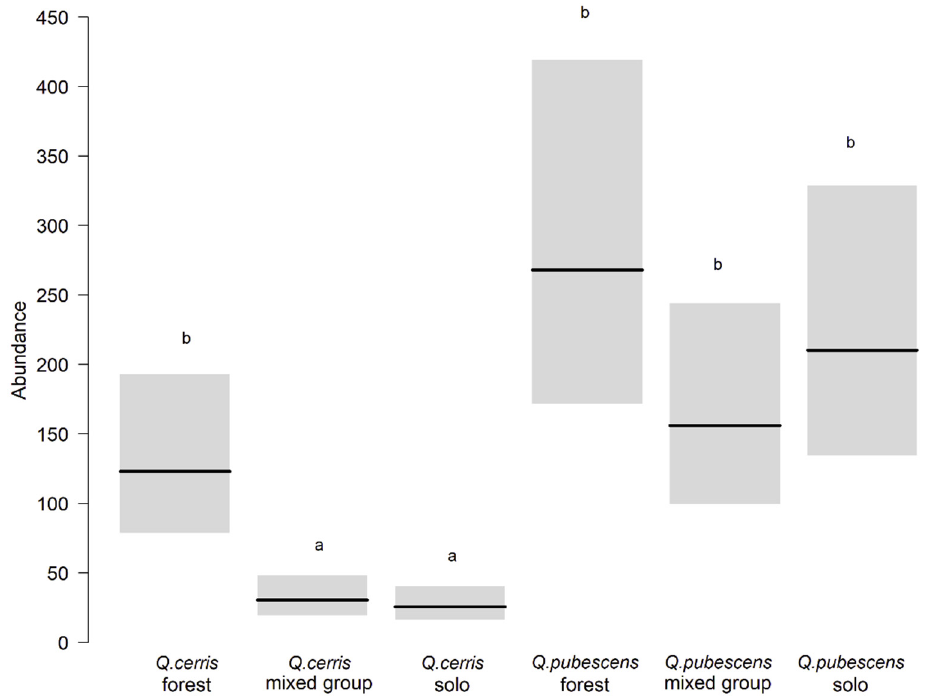
Figure 2. Abundance of caterpillars (number of individuals on three branches, each 1 m long) on mature LF Quercus cerris and EF Q. pubescens located in the forest interior (forest) and out of it, in mixed tree groups composed of Q. cerris and Q. pubescens , and on lone (solo) trees. A horizontal line denotes the mean, and bars the 95% confidence intervals. Distinct letters above columns indicate a significant difference.